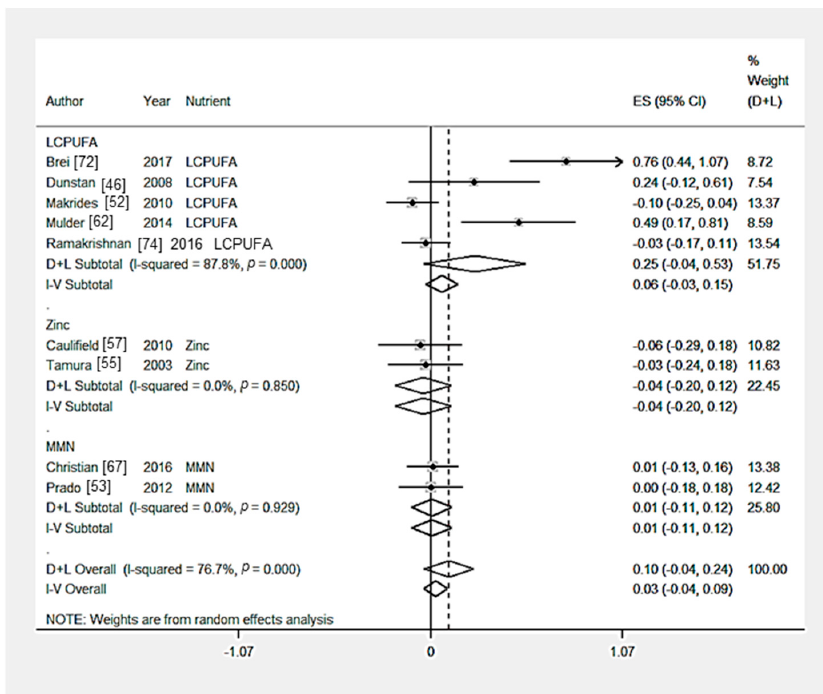
Figure 6. Forest plot for child crystallised intelligence outcomes. The overall effect size was estimated by standardised mean difference (SMD). LCPUFA, long chain polyunsaturated fatty acids; MMN, multiple micronutrient. D+L, random-effects estimate (Der Simonian and Laird method) and I-V, fixed-effects estimate (inverse variance method).